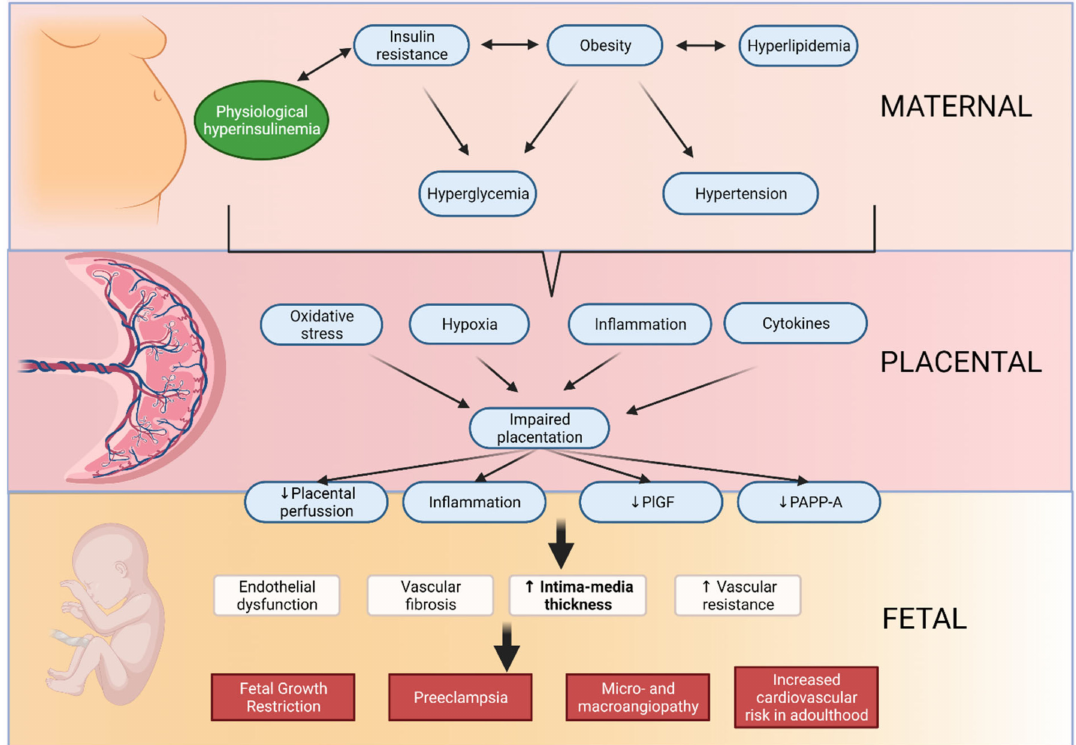
Figure 2. Maternal metabolic adaptation affecting vascular intima-media